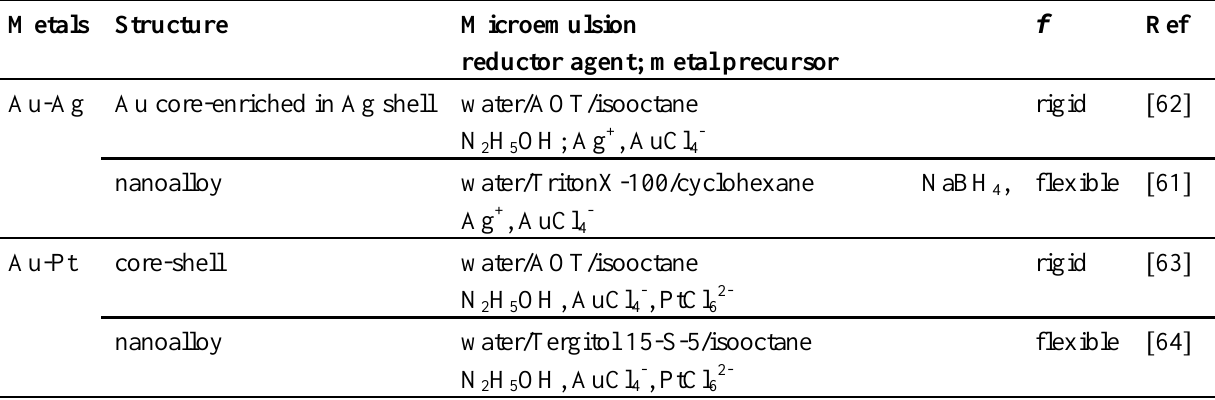
Table 1 . Bimetallic nanoparticles prepared by simultaneous reduction in microemulsions.